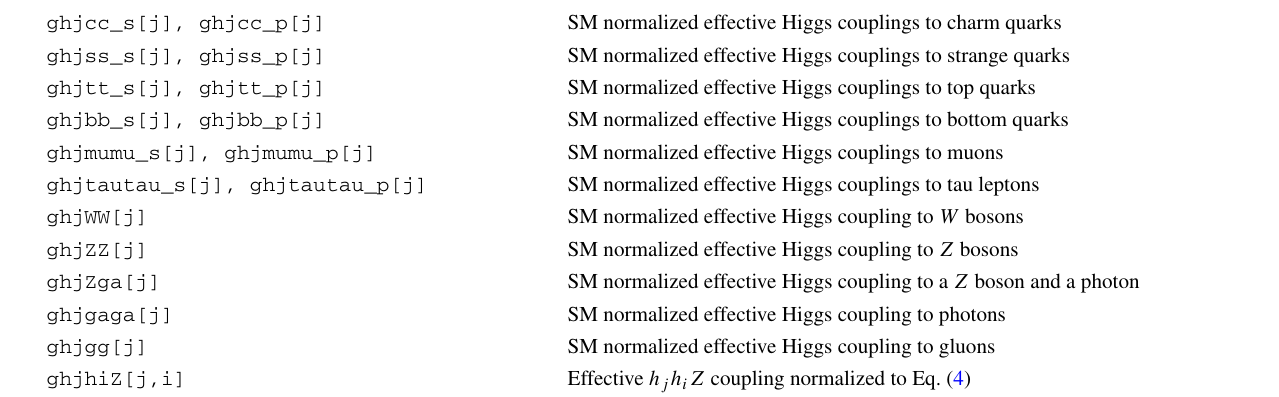
Table 4 Effective Higgs couplings for neutral Higgs bosons. The fermionic couplings have a CP-even scalar (_ s ) and a CP-odd pseudoscalar (_ p ) part. All of these are (NEW) as they are now non-squared and